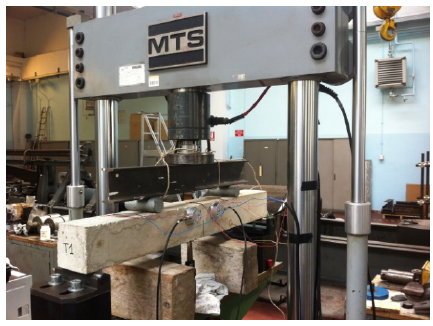
Figure 4. Experimental set ‐ up of the four ‐ point bending test.